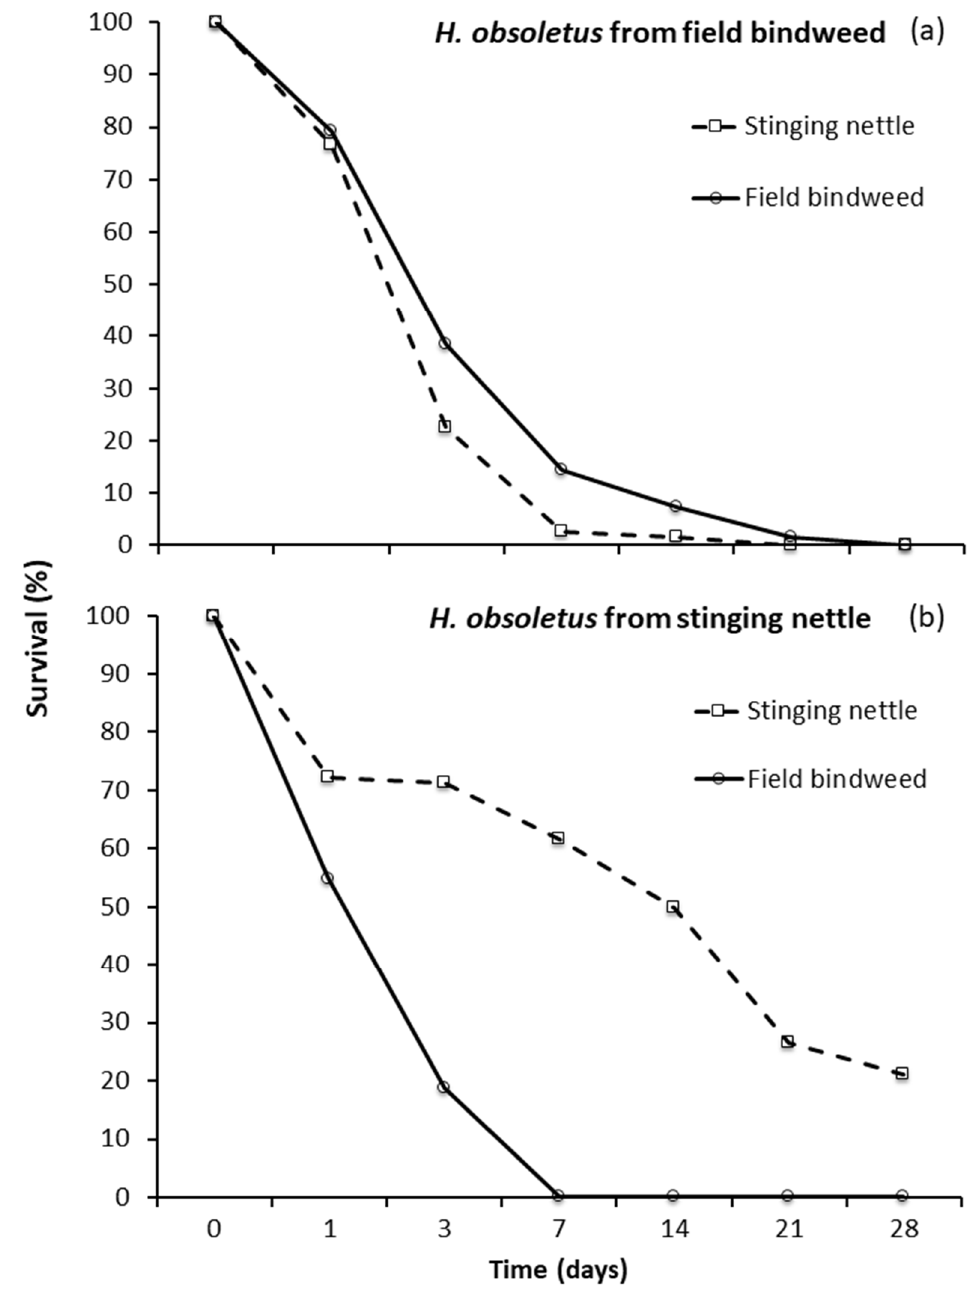
Figure 2. Survival in caged pot plants of Hyalesthes obsoletus adults: emerged ( a ) from field bindweed or ( b ) stinging nettle and released on both plants.